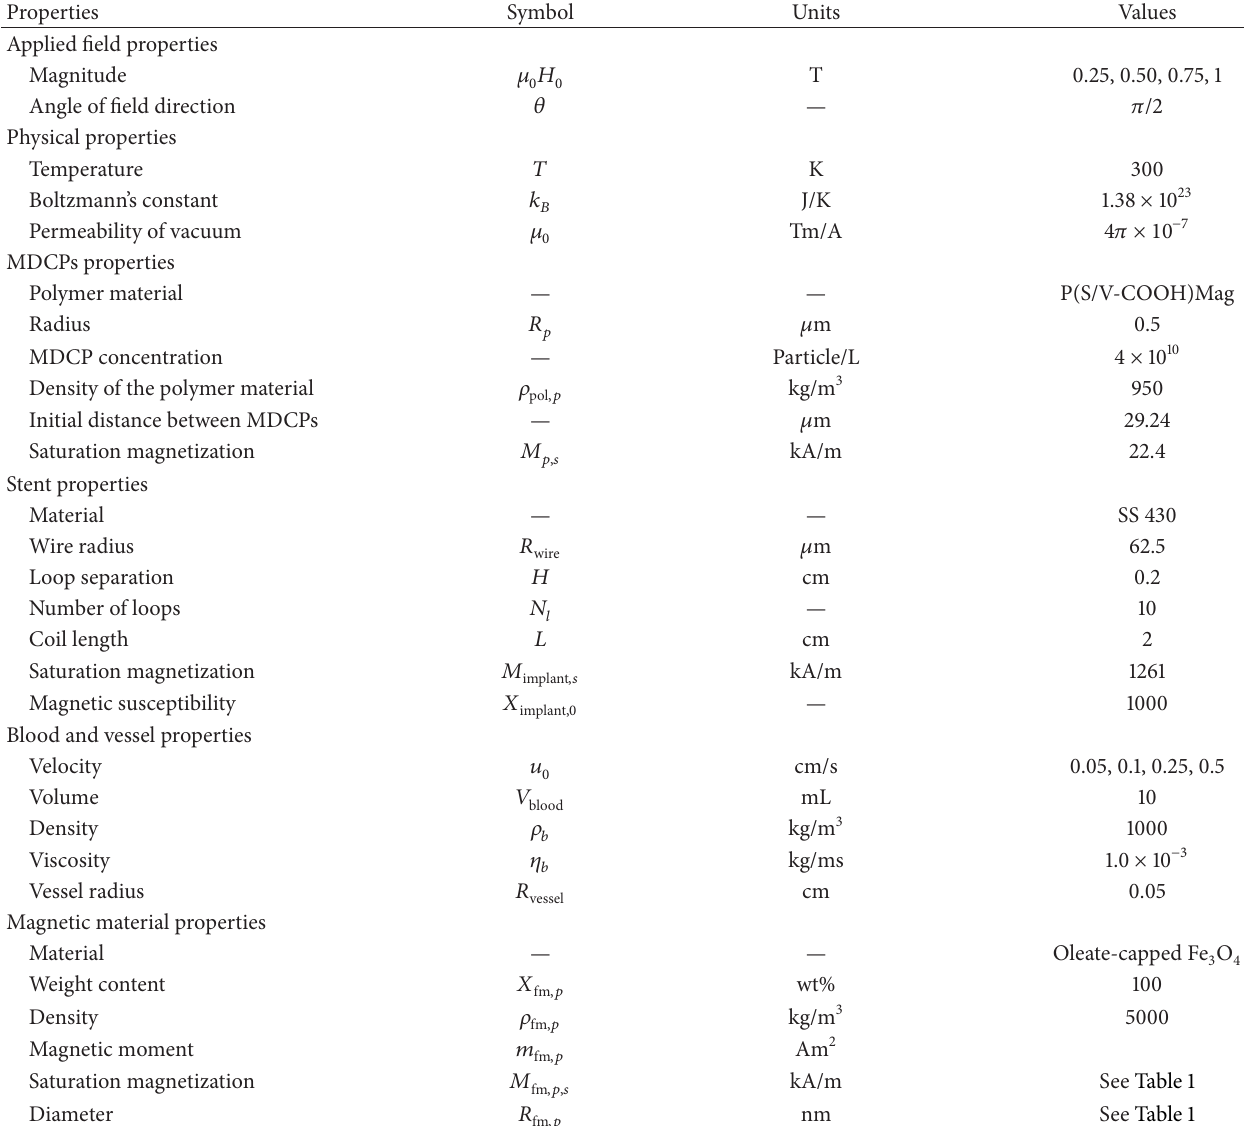
Table 2: Blood and material parameters used in the SA-MDT